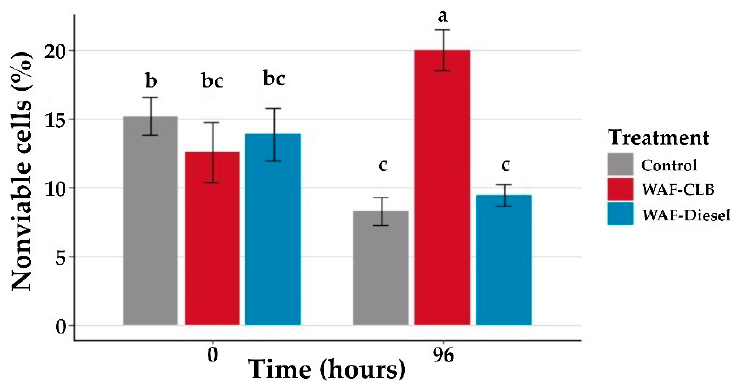
Figure 4. Fractions of nonviable lobster’ hemocyte cells for each treatment (Control, WAF-CLB, and WAF-Diesel) before (0 h) and after 96 h of exposure. Series A and B are combined; Mean ± SE; n = 6. The letter symbols indicate a significant (p < 0.05) effect between time and treatment.